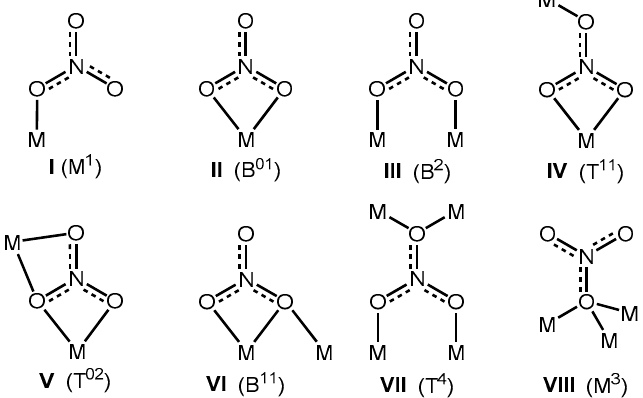
Figure 2. Crystal structure of 2 : ( a ) ORTEP plot of the coordination environment around the Cu(II) center (30% probability ellipsoid). Weak Cu ··· O semi-coordinations are shown as dashed lines. Symmetry code: #1, − x , y + 1 / 2, − z + 1 / 2. ( b ) View of the 1D zigzag chain structure. ( c ) Highlight the R 2 hydrogen-bonding pattern between two carboxyl groups of two HL salpyca − ligands in two neighboring chains. ( d ) A 2D supramolecular wavy sheet supported by O carboxyl –H ··· O carboxyl hydrogen bonds (dashed lines).